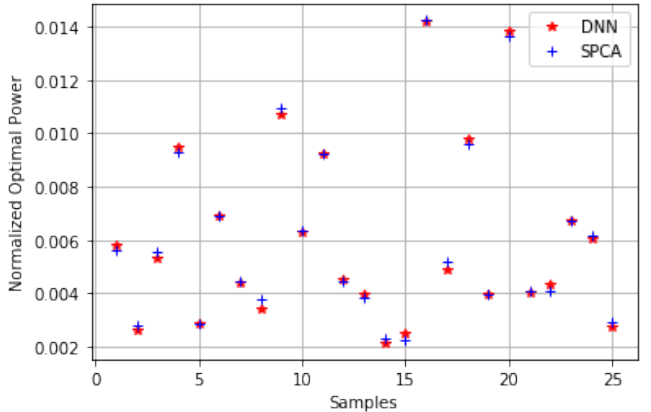
Figure 7. Optimal power samples from the DNN and SPCA for K = 2.